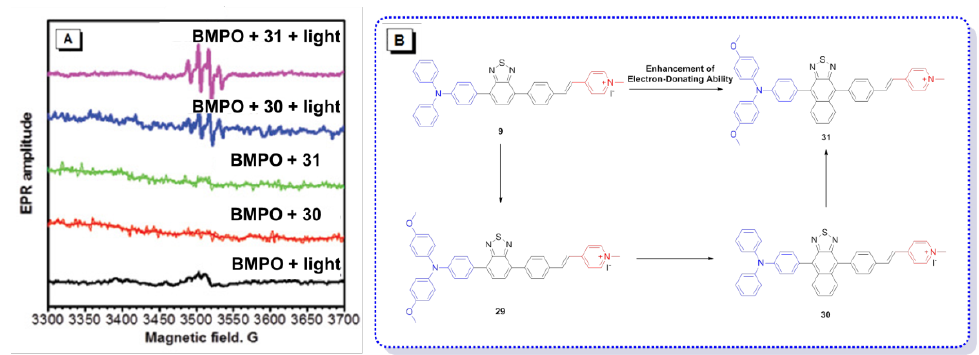
Figure 11. ( A ) EPR signals of BMPO for free radical ROS characterization. Adapted and modified with permission from reference 54 (copyright 2020, Wiley-VCH). ( B ) Chemical structures of AIE – PSs 9 , 29 – 31 (the donor and acceptor groups are represented by the blue and red scheme, respec- tively).